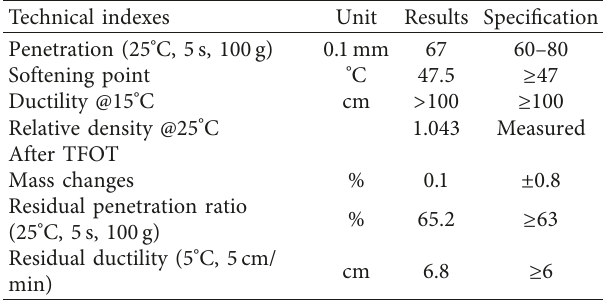
Table 1: Technical indexes of ESSO A-70 matrix asphalt.